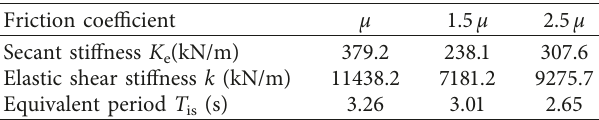
Figure 16: Five columns frame: different deployments of the sliding devices: circle normal friction coefficient and squar- (cid:31) e increased friction coefficient. (cid:31) Table 3: Five columns frame: characteristics of the four perimetral